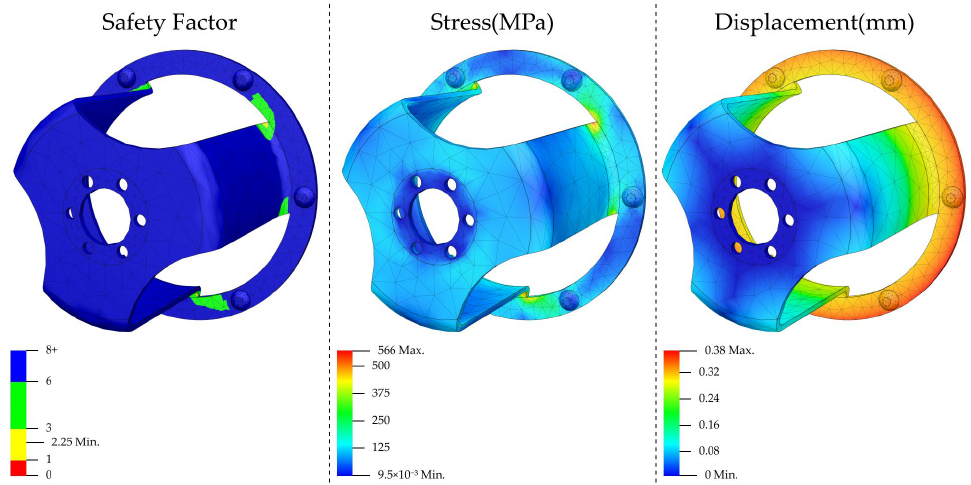
Figure 11. Analysis of condition 1 for hip connector 2. From left to right are safety factor, stress, and displacement.